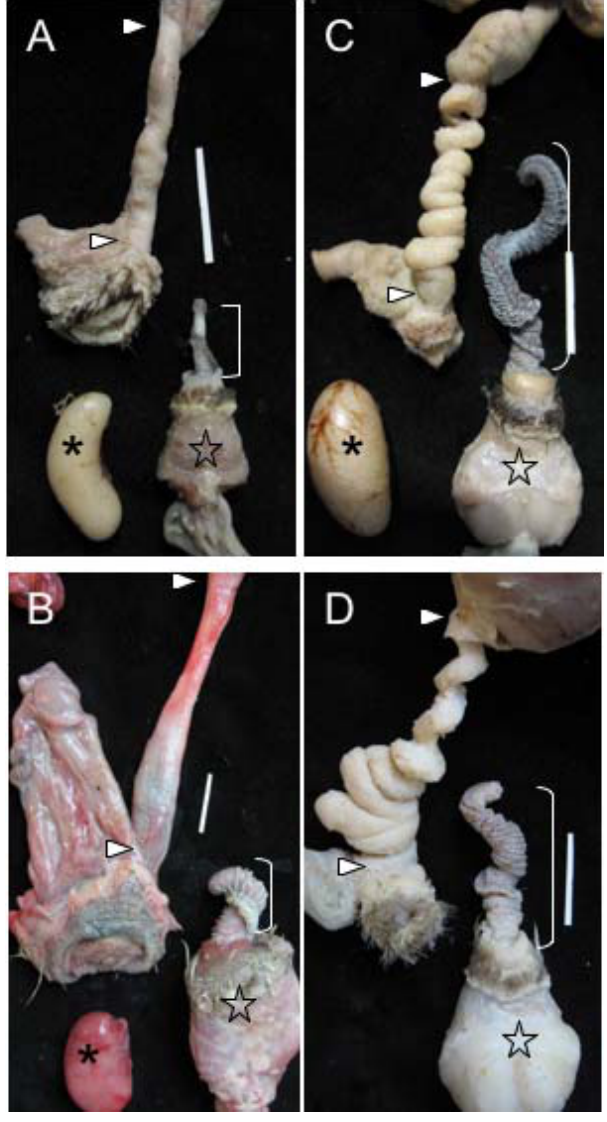
Figure 2. Examples of genital covariation in waterfowl. (A) Harlequin duck ( Histrionicus histrionicus) and (B) African goose ( Anser cygnoides ), two species with a short phallus and no forced copulations, in which females have simple vaginas as in Fig 1a. (C) Long-tailed duck ( Clangula hyemalis) , and (D) Mallard Anas platyrhynchos two species with a long phallus and high levels of forced copulations, in which females have very elaborate vaginas (size bars=2 cm). ]=Phallus, * =Testis, w =Mus- cular base of the male phallus, x =upper and lower limits of the vagina.